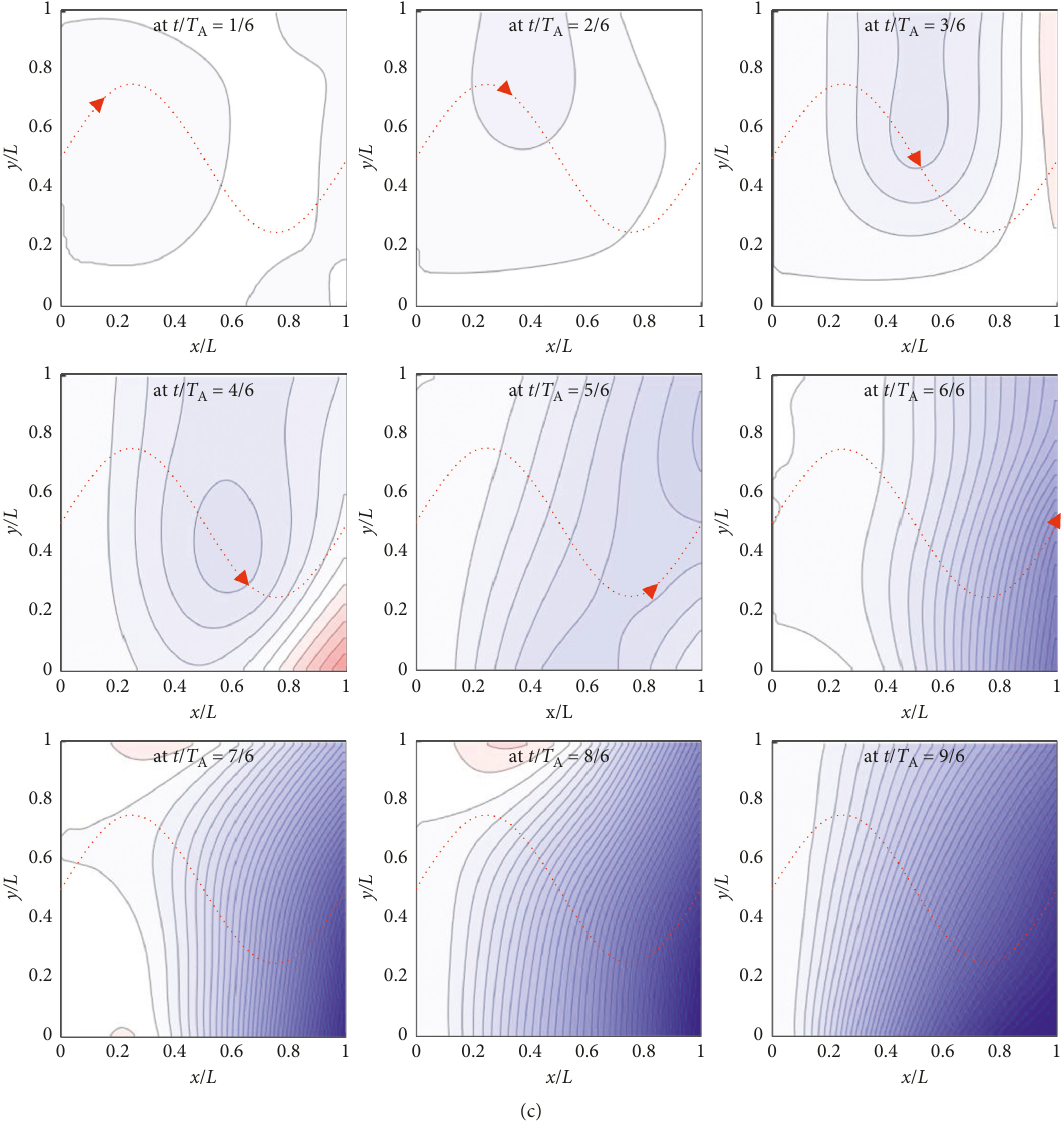
Figure 23: (a) Effects of the trajectory of a moving point force on the deformed shape of the C-F-F-F square plate (Example 3) when the moving point force travels at v 0 5m/s along the trajectory given by Case 1 of (39), where the red arrow indicates current position of the moving point (cid:31) force. (b) Effects of the trajectory of a moving point force on the deformed shape of the C-F-F-F square plate (Example 3)) when the moving point force travels at v 0 5m/s along the trajectory given by Case 2 of (39), where the red arrow indicates current position of the moving point (cid:31) force. (c) Effects of the trajectory of a moving point force on the deformed shape of the C-F-F-F square plate (Example 3) when the moving point force travels at v 0 5m/s along the trajectory given by Case 3 of (39), where the red arrow indicates current position of the moving point (cid:31)